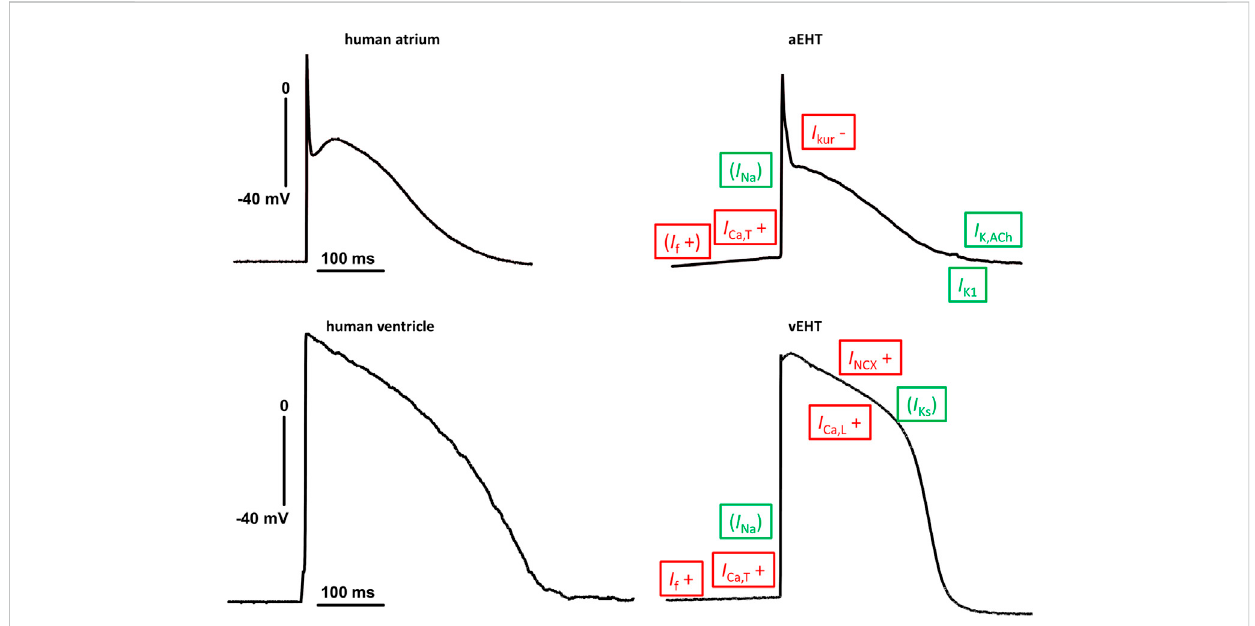
FIGURE 1 Similarities and differences in action potential shapes between adult human heart tissue and engineered heart tissue based on hiPSC-CM. Typical original traces of action potentials (AP) recorded in human adult (left) and engineered heart tissue (EHT, right) from atrium (top) and ventricle (bottom). Same scaling and zero voltage level for all four pictures. Differences in ion currents are indicated with red letter with + or − indicating changes related to adult tissue. Ion currents within the same range are indicated in green letter. Letters are given in brackets for ion currents where differences are suspected from AP recordings (no direct comparison of patch clamp data). Abbreviations: I Ca,L , L-type Ca 2+ -current; I Ca,T , T-Type Ca 2+ -current; I f , hyperpolarization-activated funny current; I K,ACh , Acetylcholine-activated potassium current; I Ks , slow delayed recti fi er potassium current; I Kur , ultrarapidly activating potassium current; I K1 , inward recti fi er potassium current; I Na , sodium current; I NCX , Na + /Ca 2+